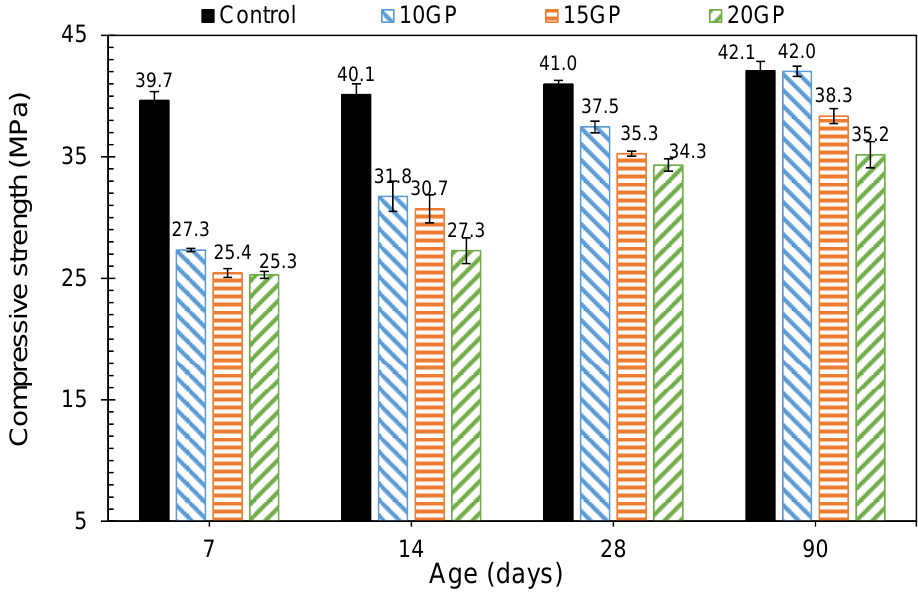
Figure 11. Compressive strength of CEM I and GP mortars.